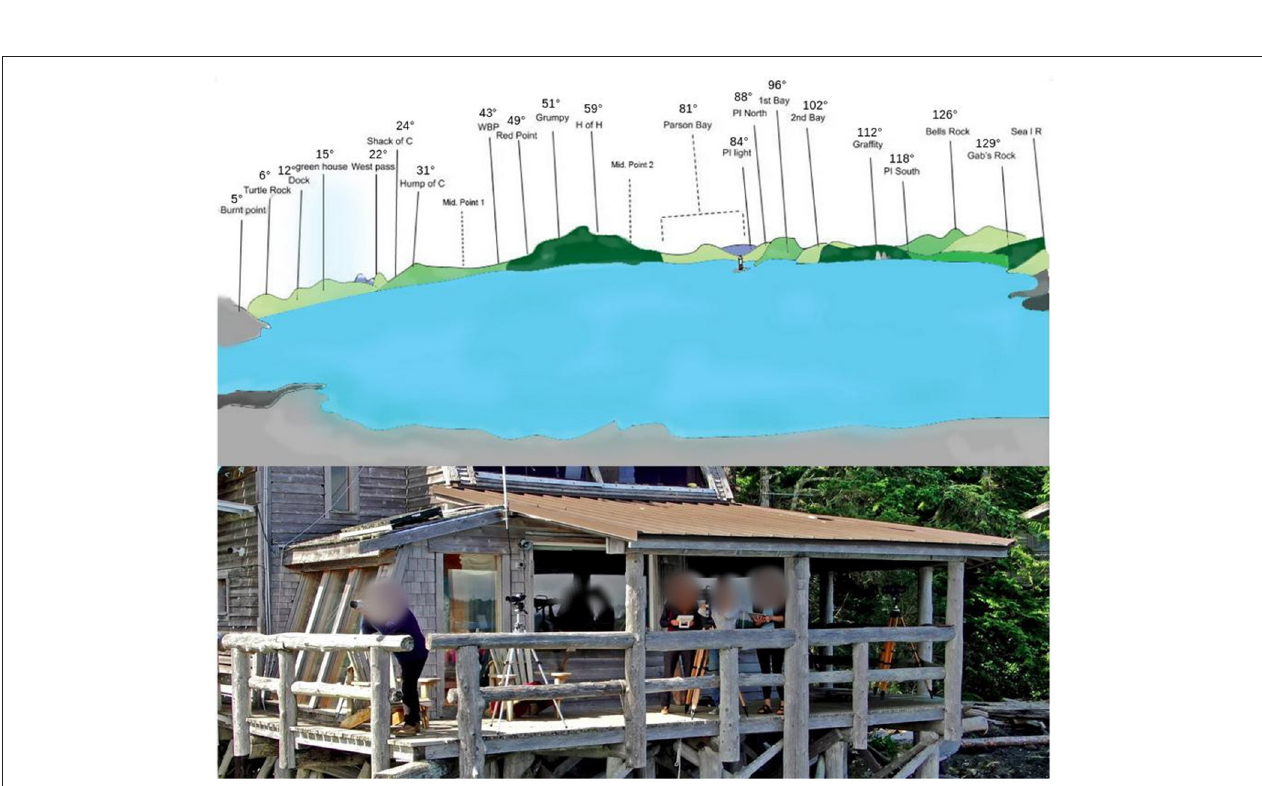
FIGURE 2 | (Top) Representation of the view of Blackney Pass from Orcalab. Each site was assigned a precise azimuth using a compass (e.g., “Pi Light” = 84 degrees.). (Bottom) Picture of the visual protocol.